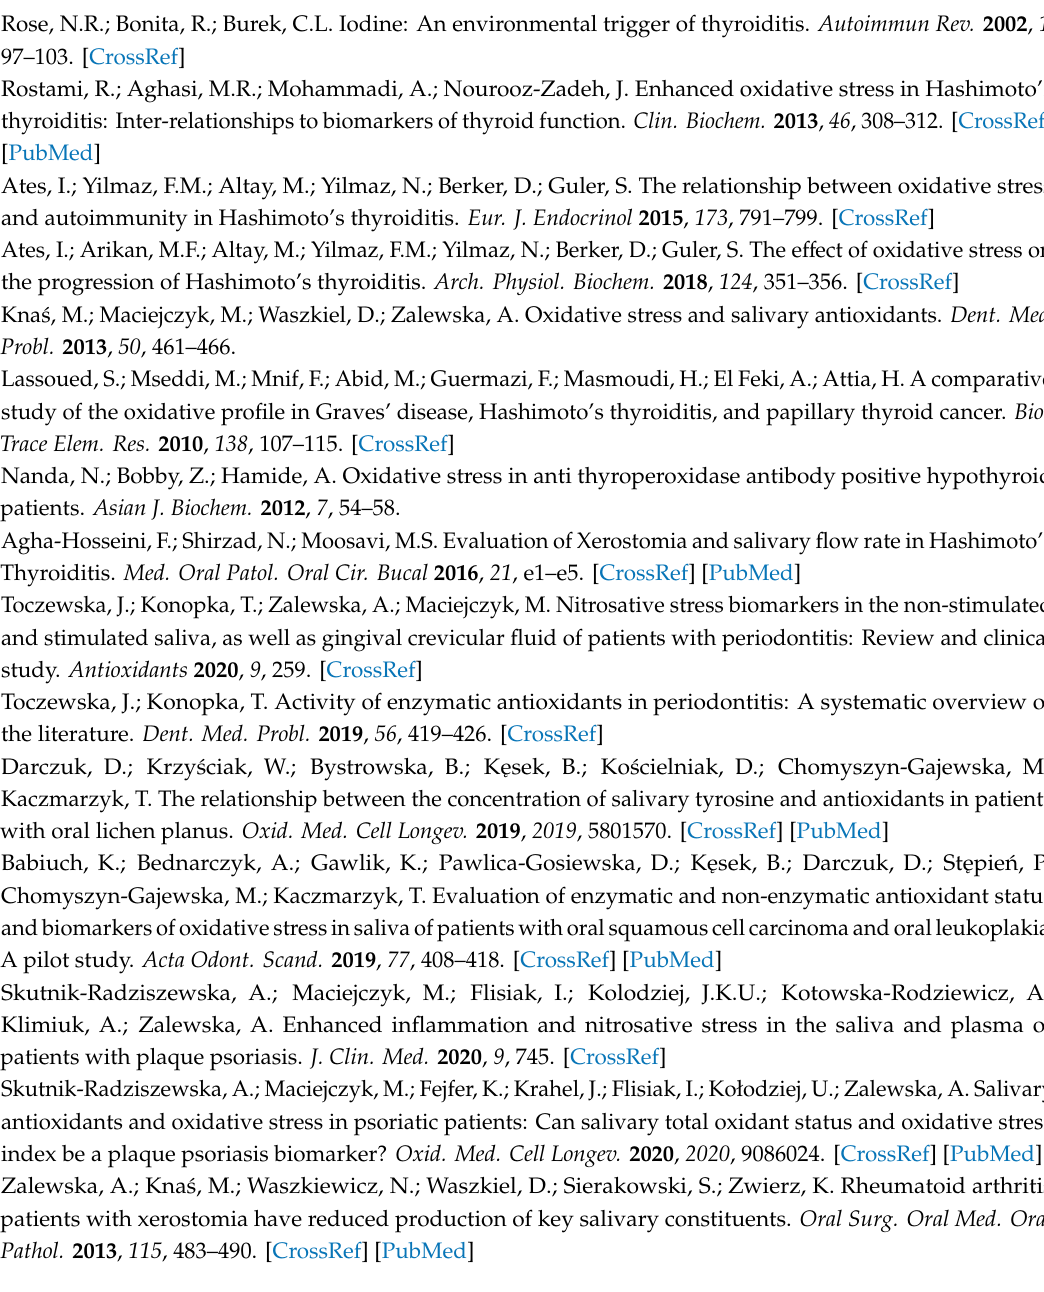
Table S1: Spearman r coeficient of variables, Table S2: p value of